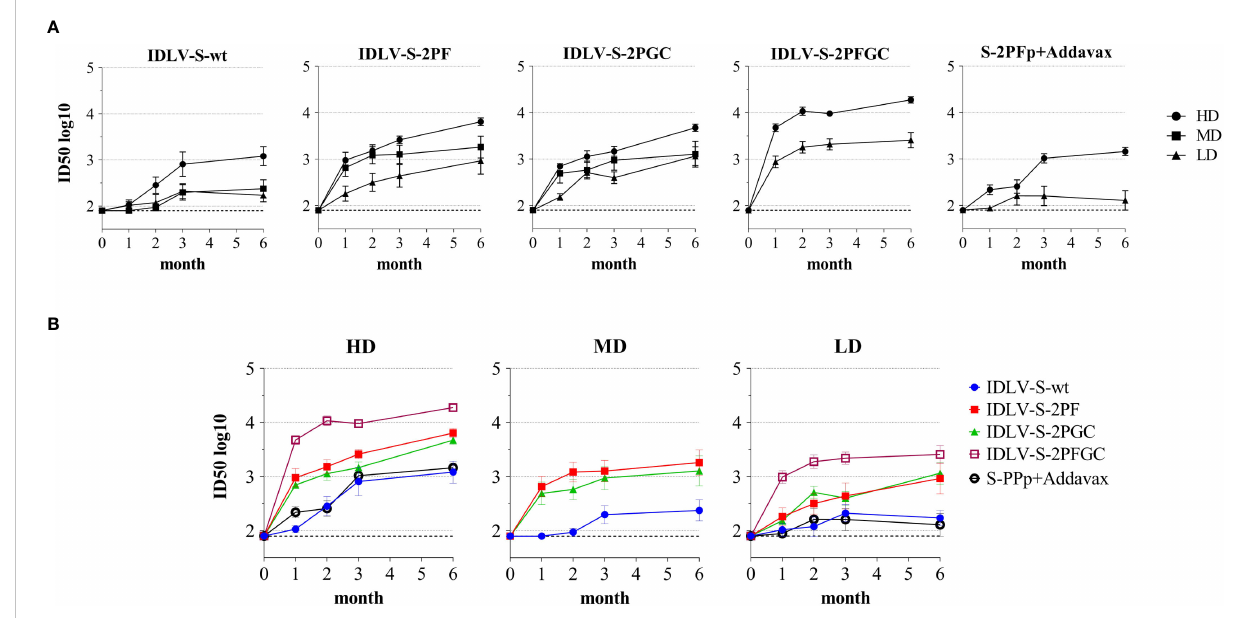
FIGURE 4 Kinetics of neutralizing antibodies in immunized mice. Anti-Wuhan neutralizing antibodies (nAbs) were evaluated at different time points (month) from immunization in sera of mice immunized with the indicated vaccines. Results are expressed as mean ID50 ± SEM with N=5-6 animals per group. HD, MD and LD: high, medium and low dose of vaccine, respectively. The dotted line indicates the assay cut off (minimum serum dilution tested 1:80 dilution). (A) Each graph shows results from mice of the same vaccine group at HD, MD and LD. (B) Each graph shows different vaccine groups at the same